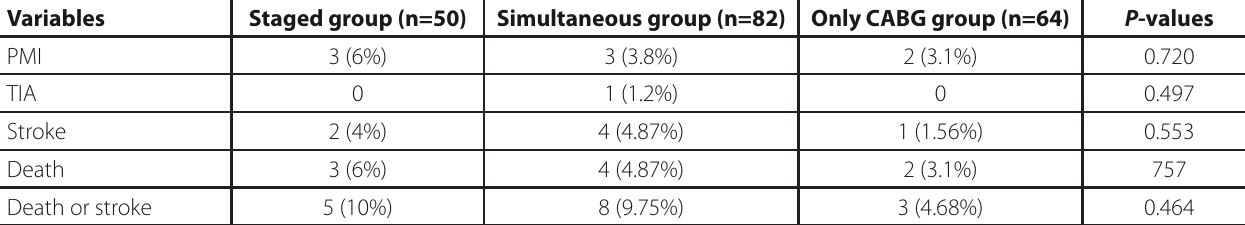
Table 2. Operative in-hospital 30-day results.